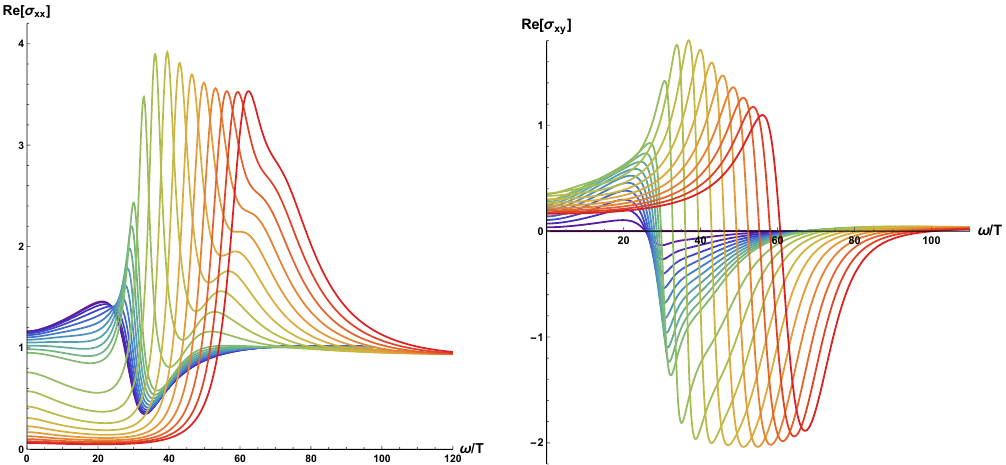
Figure 17 . The evolution of the pseudo-phonon peak increasing the magnetic (cid:12)eld. We move the magnetic (cid:12)eld B=T 2 2 [0 ; 5 (cid:2) 10 3 ] (from blue to red). The other parameters (cid:26)=T 2 = 987 ; (cid:20)=T = 31 : 4 ; (cid:11) = 0 : 1 ; (cid:12) = 2 are kept (cid:12)xed.